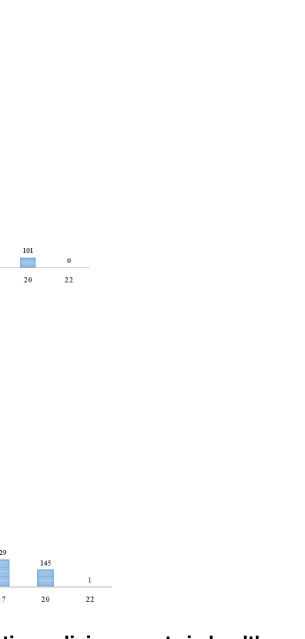
Fig 3. Genes and their patterns of alternative splicing events in healthy and mastitic cow ’ s mammary gland tissue. The red and green histograms show the numbers of genes and the corresponding numbers of alternative splicing events,